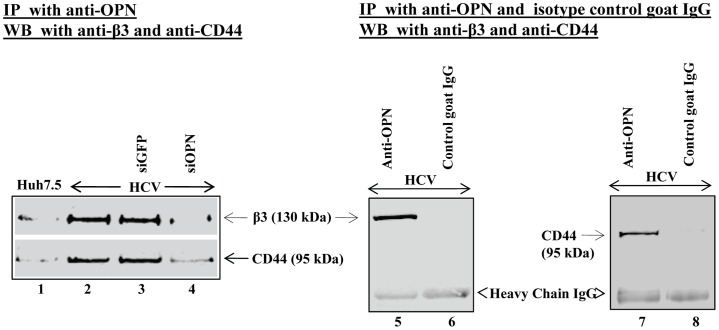

Interaction of OPN with integrin αVβ3 and
                            CD44.
HCV-infected Huh7.5 cells were transfected with siGFP and siOPN as
                            described in Materials and Methods. At 72 h posttransfection, equal
                            amounts of cellular lysates from mock, HCV-infected cells and
                            HCV-infected cells transfected with above siRNA were immunoprecipitated
                            using anti-OPN (1∶100) antibody and immunoblotted with
                            anti-integrin β3 and anti-CD44 (lane 1–4). Similarly the
                            cellular lysates from HCV-infected cells were immunoprecipitated with
                            anti-OPN and isotype control goat IgG antibodies in two different sets
                            followed by immunoblot analysis using anti-β3 and anti-CD44
                            (lane 5–8).